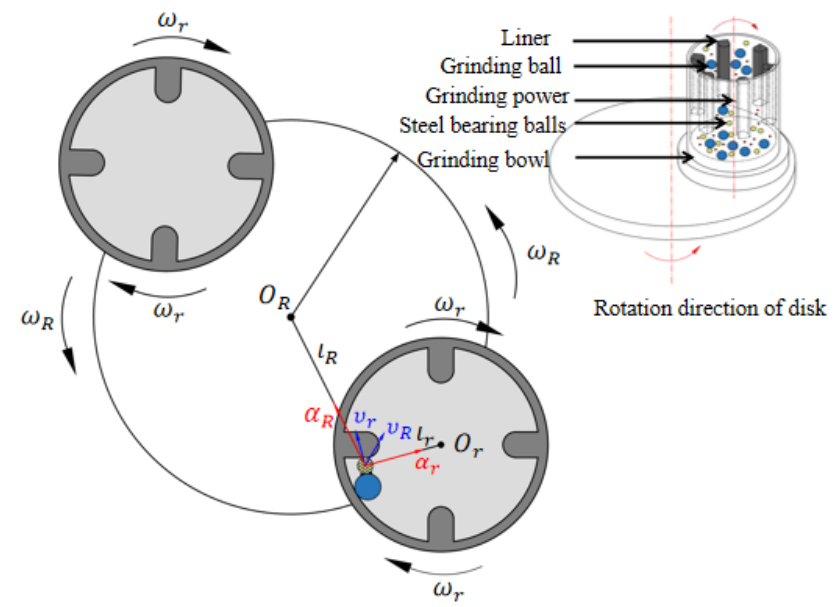
Figure 2. Schematic diagram of mechanical ball milling.